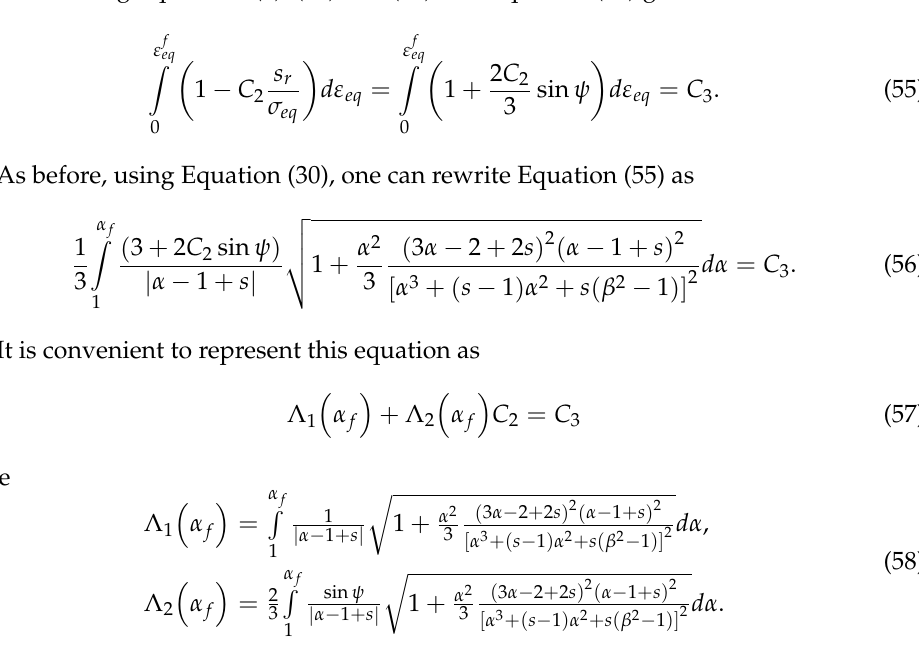
As before, using Equation (30), one can rewrite Equation (55)